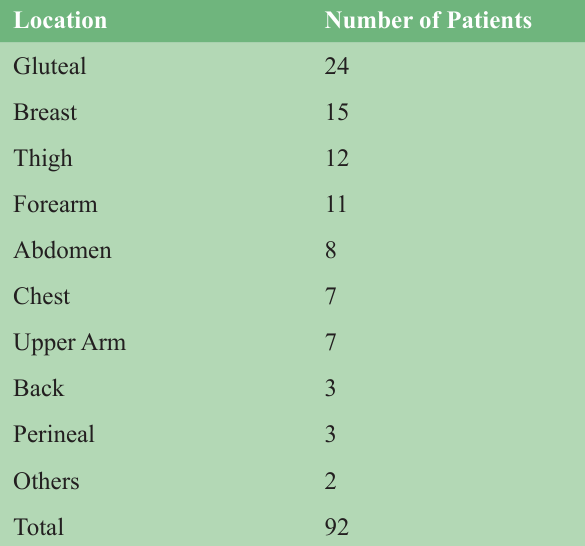
Table 1: Location of the abscess